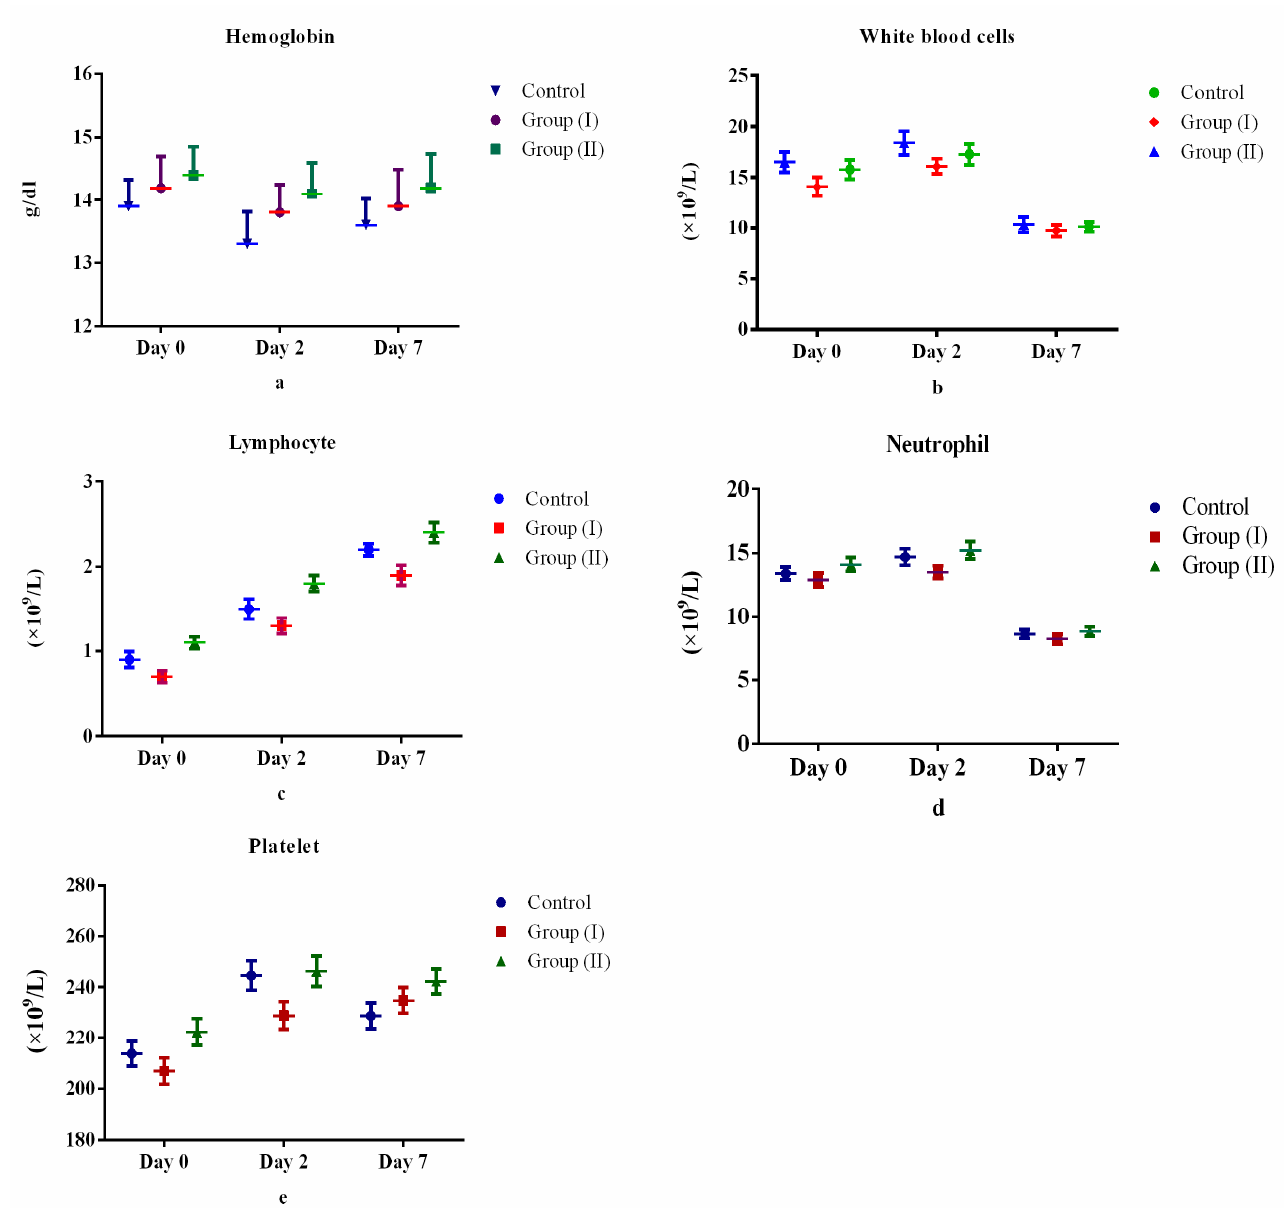
Figure 2. Comparison of complete blood count between control and treatment groups: ( a ) hemoglobin, ( b ) total white cell count, ( c ) lymphocytes, ( d ) neutrophils, ( e )